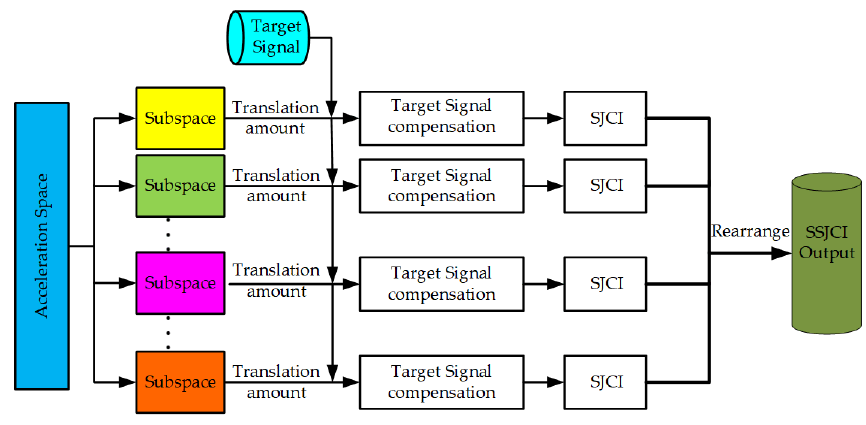
Figure 4. The flow chart of the SSJCI